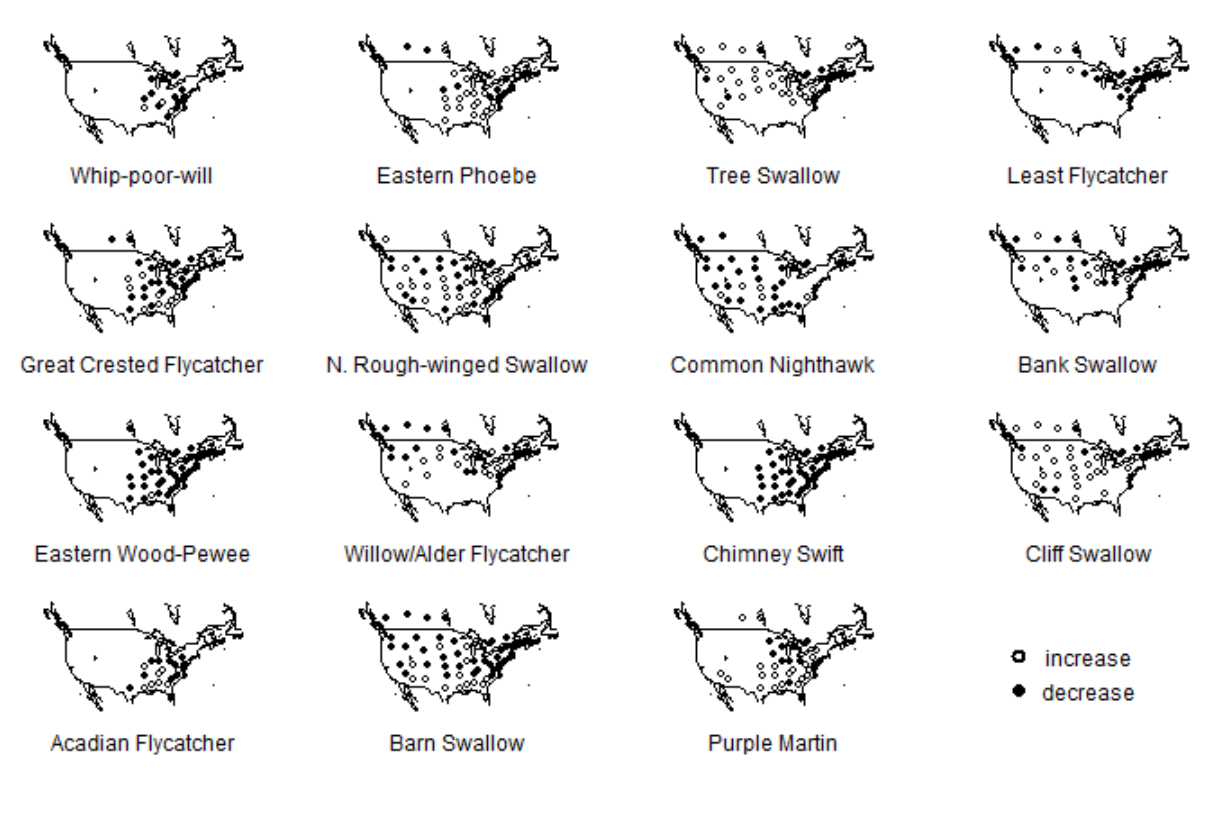
Fig. 2 . Distribution maps for a selection of 15 species of aerial insectivores showing geographic patterns of population trends, according to the Breeding Bird Survey (1966 to 2006) (Sauer et al. 2007). Jurisdictions where a species was present on fewer than 15 routes were not